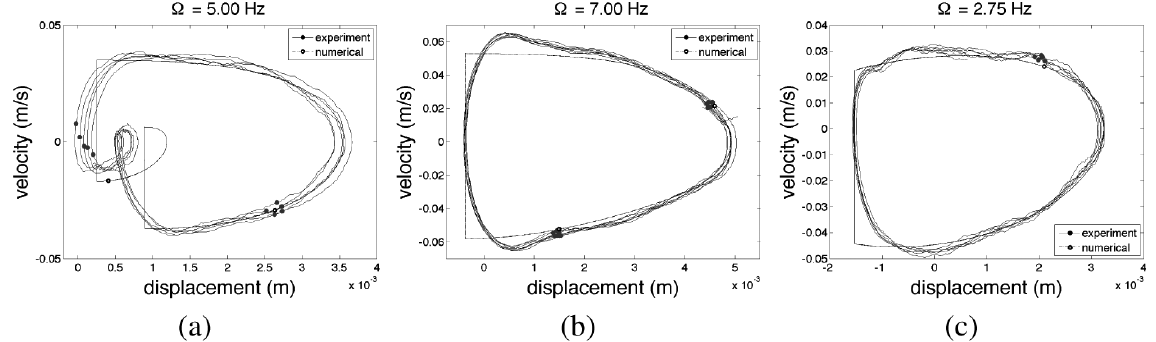
Fig. 12. Phase plane and Poincar´e maps, comparison between numerical simulation (blue) and experimental results (red): a) Gap 0.0 mm, Ω /ω = 2.7; b) Gap 0.0 mm, Ω /ω = 3.8; c) Gap 1.0 mm, Ω /ω = 1.5.